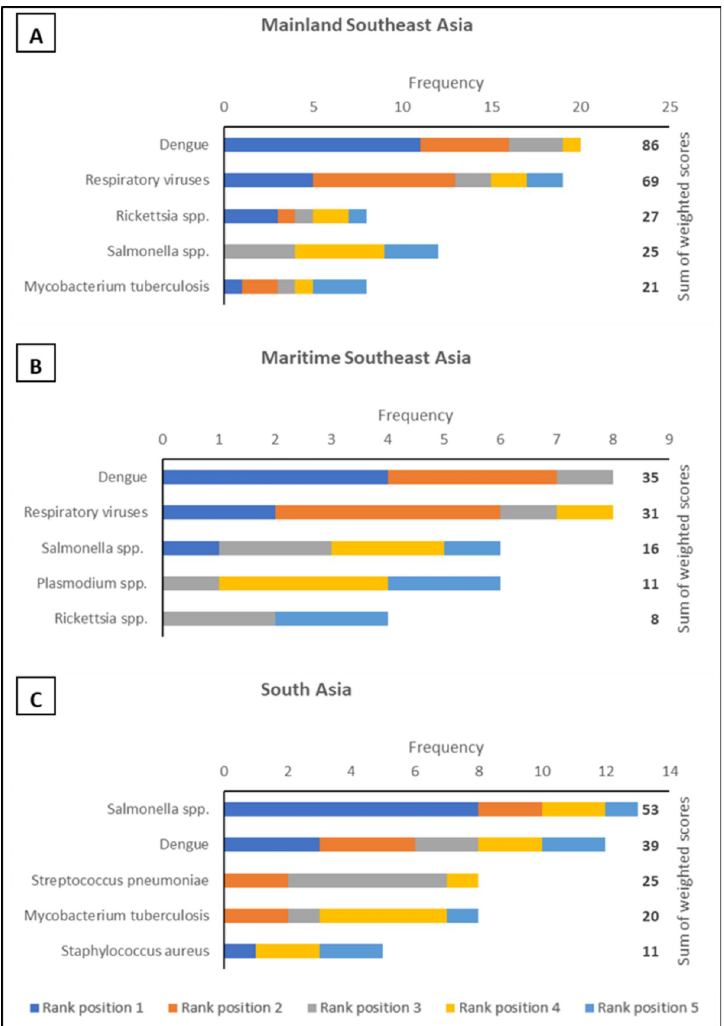
Fig 4. The top five commonest aetiologies of acute fever, in descending order of perceived annual incidence based on sum of weighted scores, in the following regions: (A) Mainland Southeast Asia (B) Maritime Southeast Asia (C) South Asia. An analyte in rank position 1 was weighted five times more than an analyte in rank position 5; the maximum sum of weighted scores per aetiology was 115 for Mainland Southeast Asia, 40 for Maritime Southeast Asia, and 65 for South